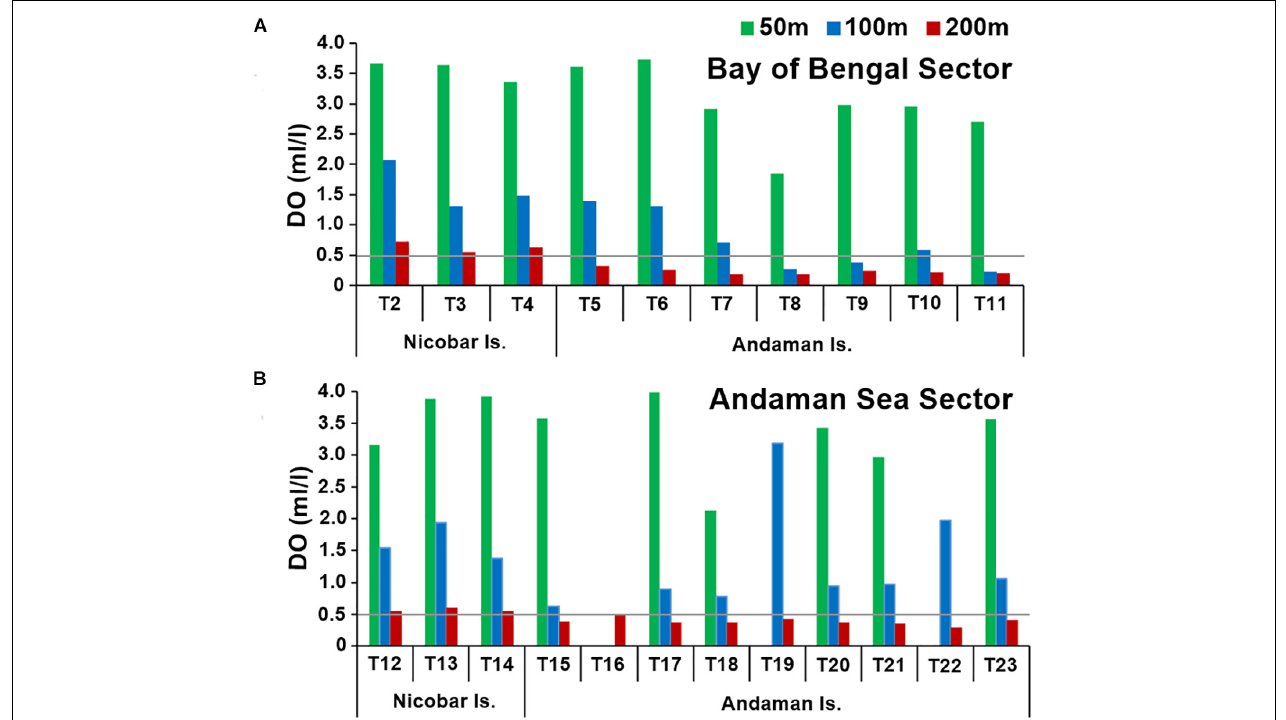
FIGURE 2 | Bottom water dissolved oxygen (ml.l - 1 ) at 50 m (green bars), 100 m (blue bars) and 200 m (red bars) depth strata in the (A) Bay of Bengal Sector (BoB) (B) Andaman Sea sector (AS).